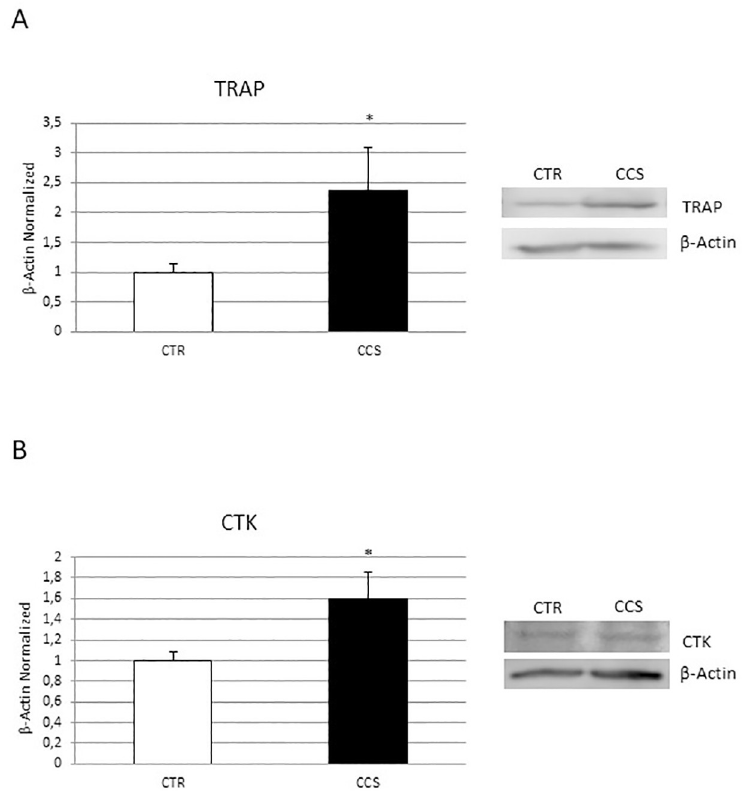
Fig 1. Characterization of OCs derived from CCS. TRAP (A), Cathepsin K (CTK) (B) protein expression in osteoclasts (OCs) from 5 Childhood cancer survivors (CCS) compared with OCs from 5 healthy subjects (CTR), determined by Western Blot starting from 15 μ g of total lysate. The most representative images are showed. The Image Studio Digits software has been used for the protein bands density detection. The intensity ratios of immunoblots compared to CTR, considered as 1, were quantified after normalization with the housekeeping protein β -Actin. Histograms represent the relative quantification for TRAP and CTK expression as mean ± SD of independent experiments on each individual sample. For statistical analysis it has been used a t-test. � Indicates p � 0.05 compared to